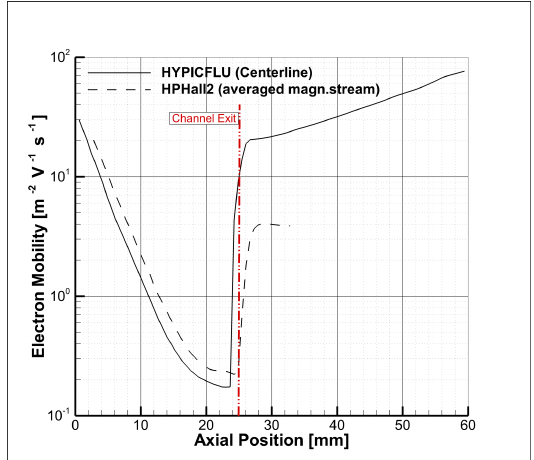
Figure 16. SPT-100 discharge: time-averaged mobility as a function of axial position. Comparison between HYPICLFU (Test 106: data taken along channel centreline) and HPHall2(data averaged over magnetic streamlines, reconstructed from Ref.